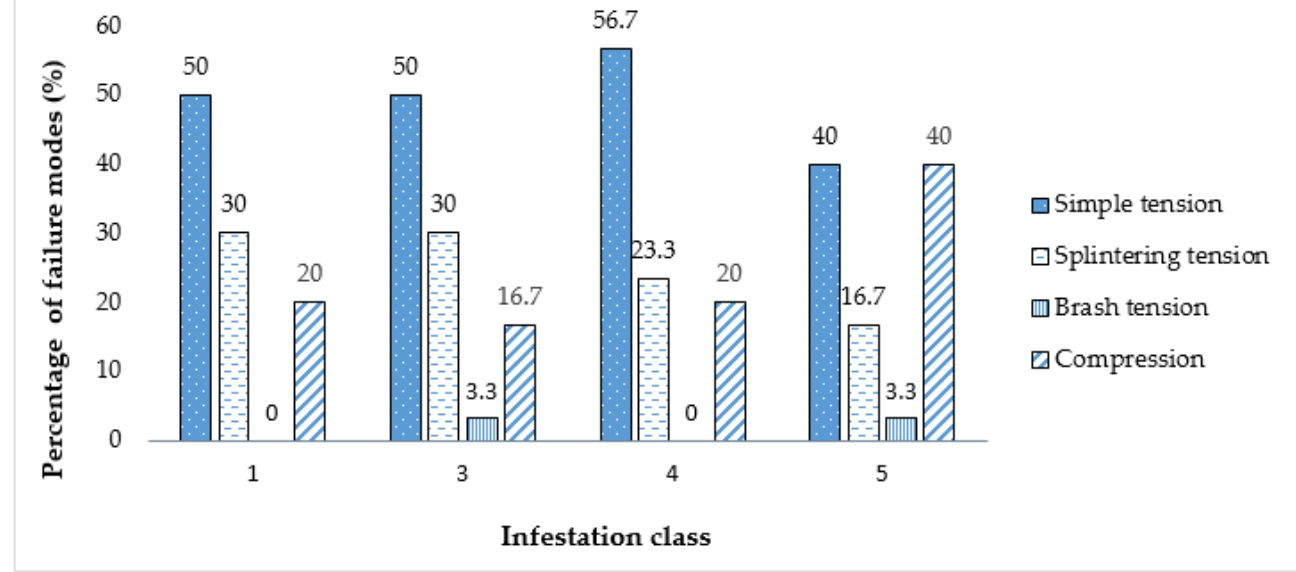
Figure 7. Percentage of failure modes according to infection